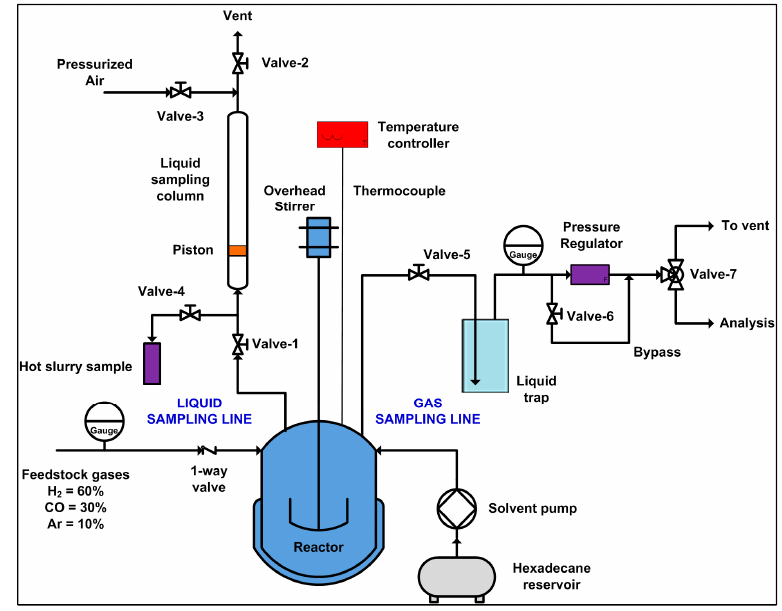
Figure 12. Design of our 3- φ -CSTSR incorporating both liquid and gas sampling